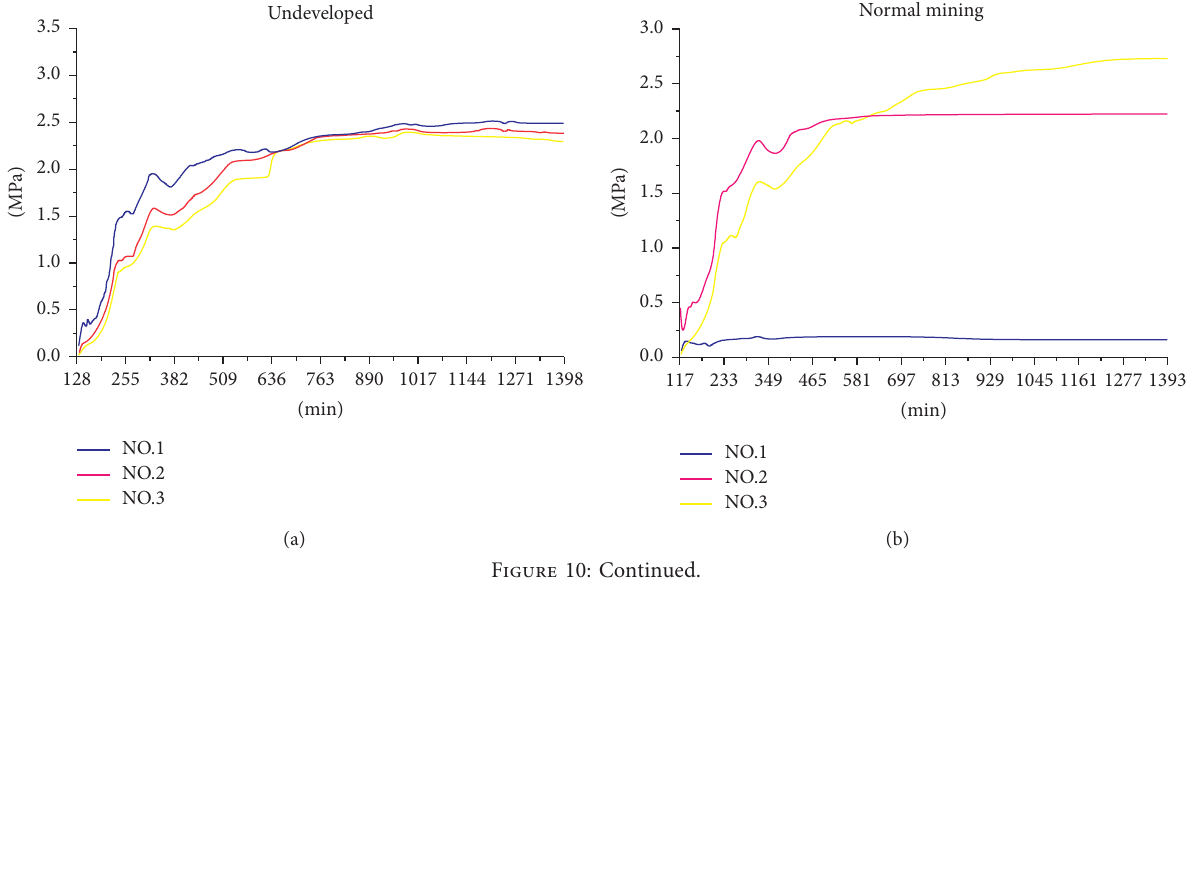
Figure 9: Stress curves of three measuring points at the top corner of the end under three conditions: (a) stress variation curves of measuring point 1 under three states; (b) stress variation curves of measuring point 2 under three states; (c) stress variation curves of measuring point 3 under three states